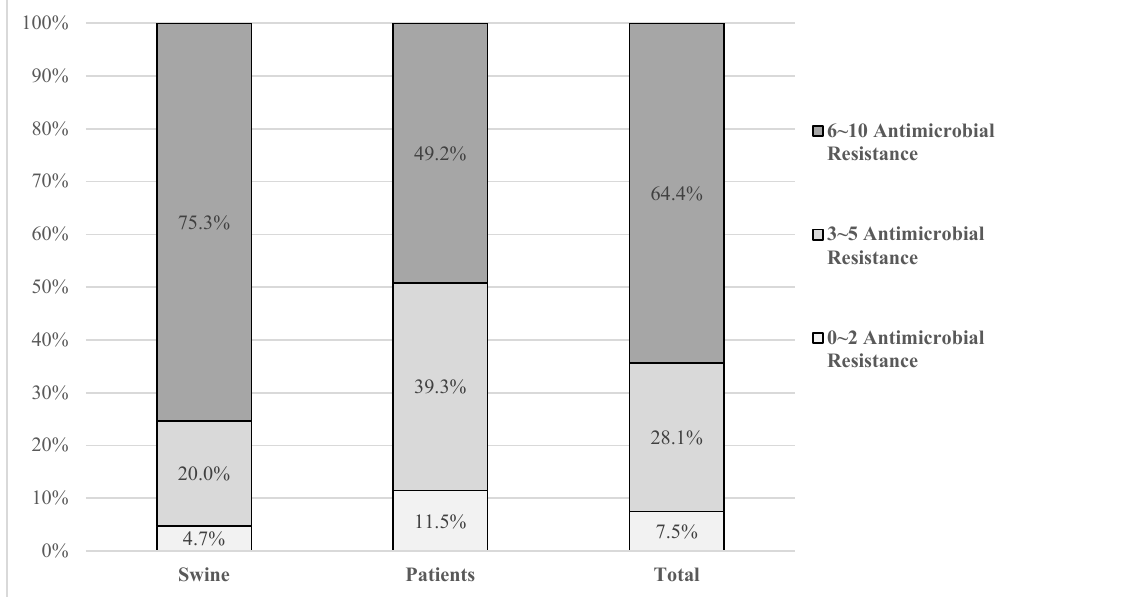
Figure 1. Multidrug resistance of E. coli from diarrheic pigs and patients in Korea. Antimicrobial subclasses defined by the Clinical and Laboratory Standards Institute (CLSI) are used.